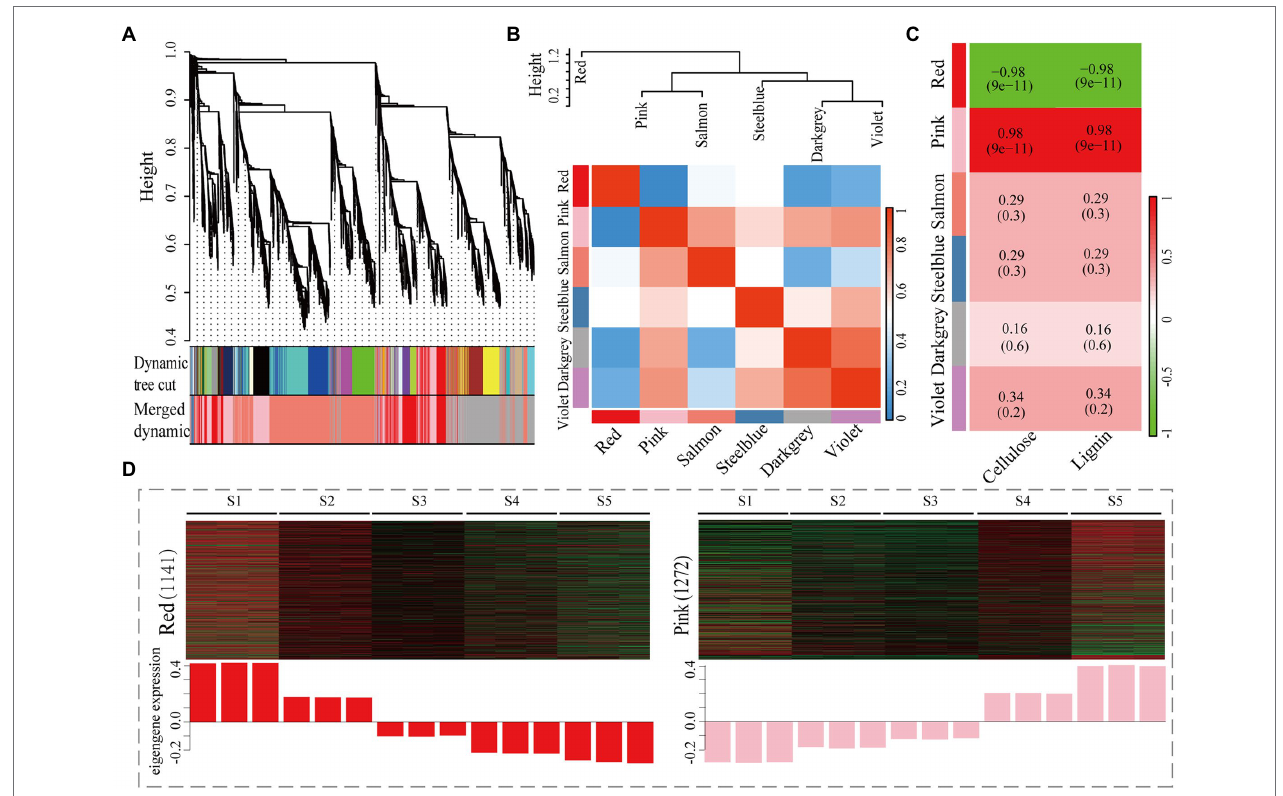
FIGURE 4 | Co-expression analysis of 6,520 DEGs and cellulose/lignin contents in C. lanceolata . (A) Clustering dendrogram of DEGs, with dissimilarity based on the topological overlap, together with assigned module colors. (B) Analysis of connectivity of eigengenes in different modules with eigengenes (above) and the heatmap of connectivity of eigengenes (below). (C) Correlations of module and cellulose/lignin contents with corresponding p -values (in parentheses). (D) Expression profile of the genes in red (A) and pink (B) modules, respectively. Heatmaps showed the expression profiles of all the co-expressed genes (number given on the left) in the samples (labelled on top). The histogram shows the average eigengene expression among different